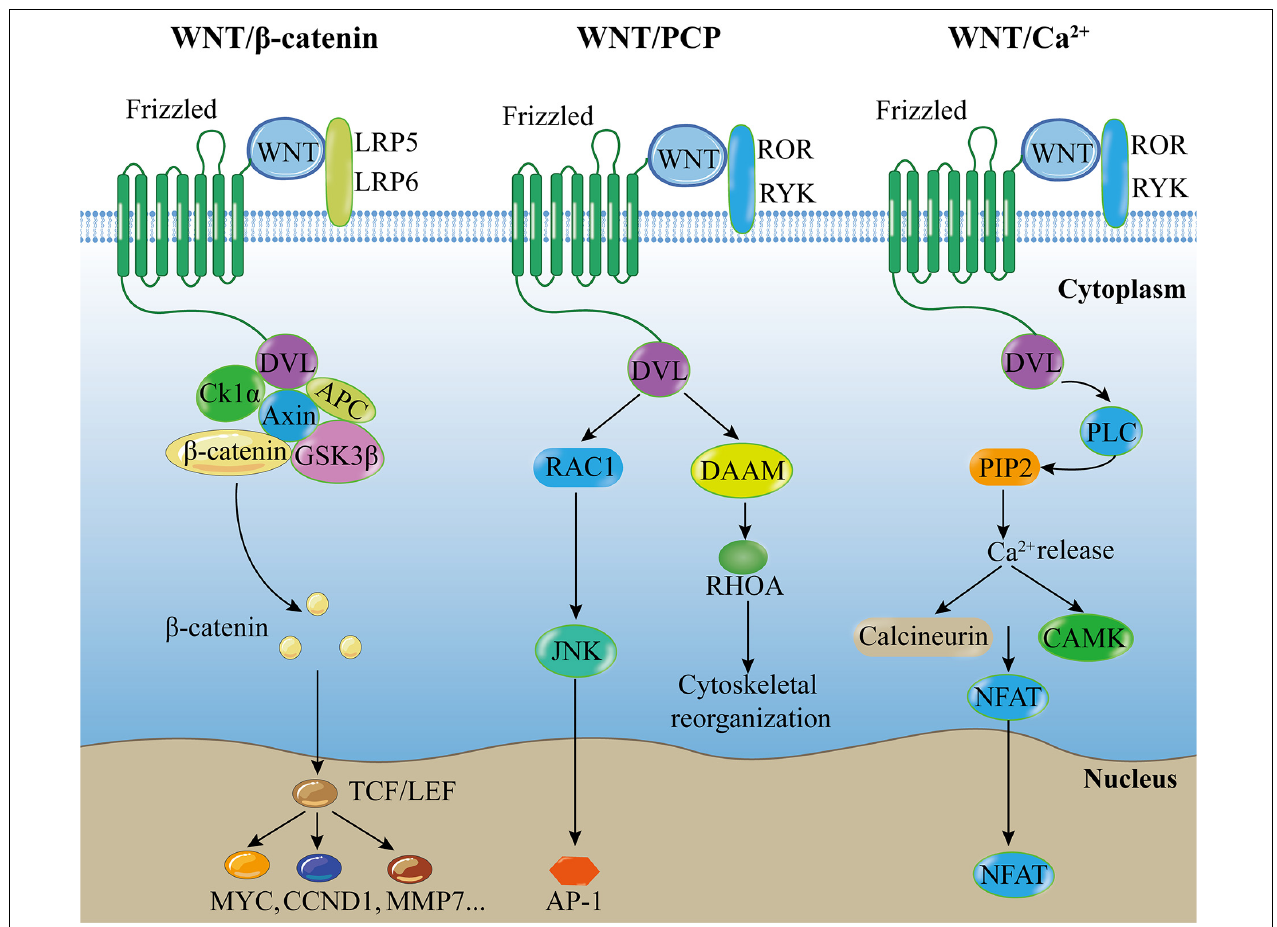
FIGURE 1 | Canonical and non-canonical WNT pathways. Canonical WNT pathway: Extracellular WNT ligands bind to FZD and LRP5/6 on the cell membrane, and recruit DVL protein to promote dissociation of the β -catenin destruction complex, followed by accumulation of β -catenin, which translocates to the nucleus to interact with target downstream signaling molecules, activating intracellular signaling cascades. WNT/PCP pathway: Extracellular non-canonical WNT ligands bind to FZD receptor and/or ROR/RYK co-receptors at the cell membrane, and recruit DVL protein to promote downstream effector components, such as RAC and RHOA signaling cascades, regulating tissue polarity and cell movement. WNT/Ca 2 + pathway: Extracellular WNT ligands bind to FZD receptor and/or ROR/RYK co-receptors at the cell membrane, and recruit DVL protein to promote PLC, leading to the formation of IP3 and DAG from PIP2, resulting in intracellular Ca 2